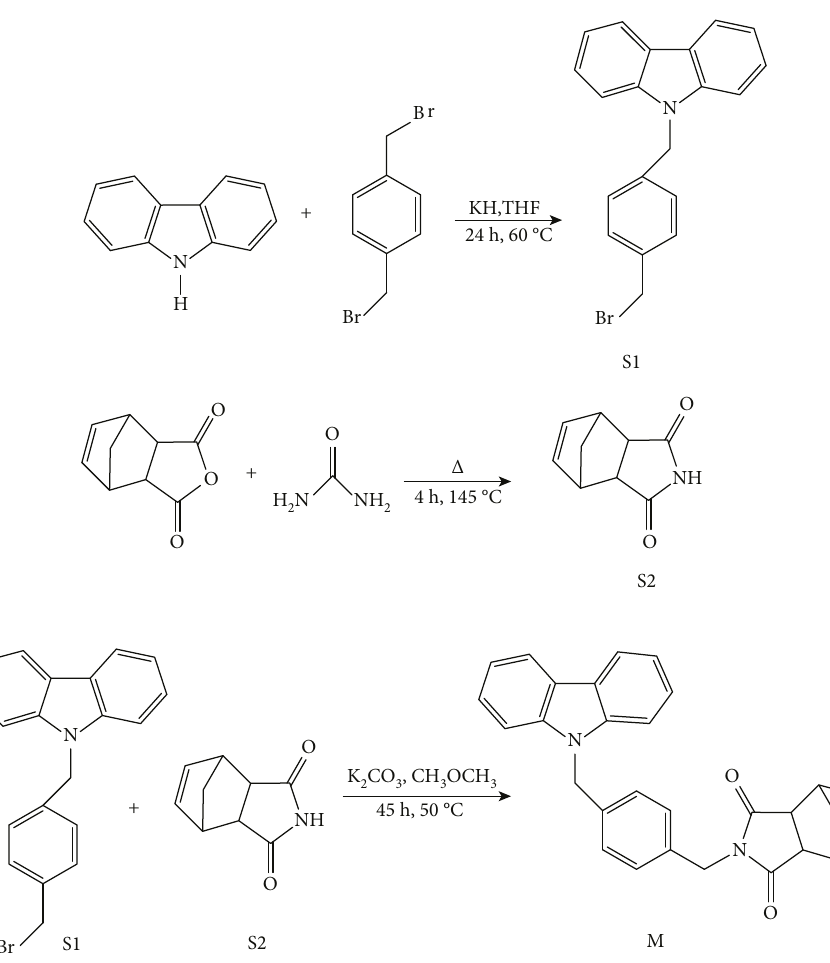
Figure 2: Monomer